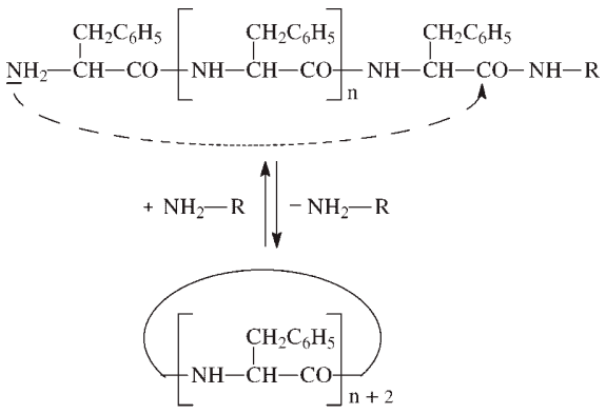
Figure 34. Formation of cyclic oligo-/polypeptides by “back-biting”.